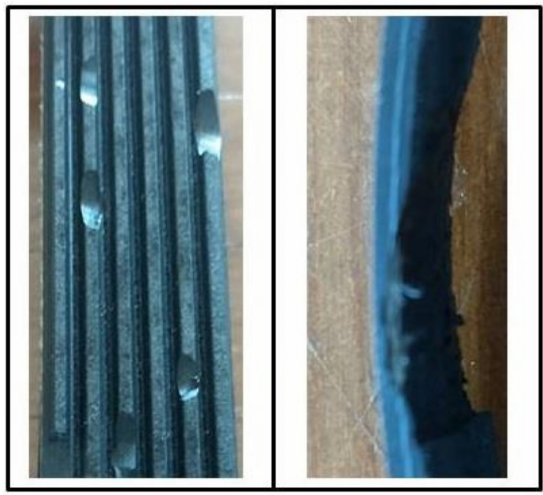
Figure 9. BPD fault ( left ) and BCL fault ( right